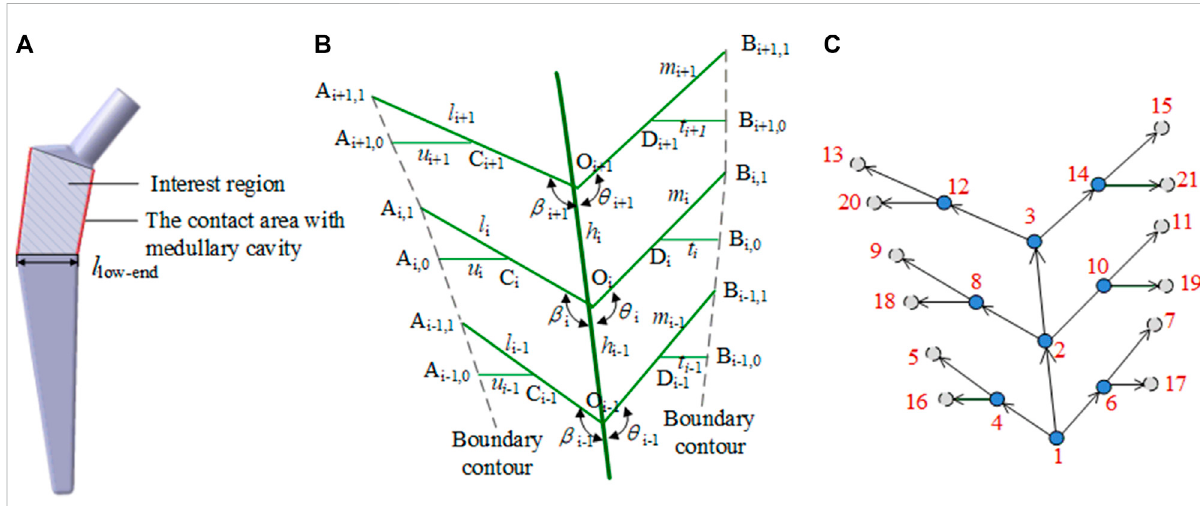
FIGURE 8 Bionic vein structure feature of the femoral stem prosthesis. (A) Interest region of the femoral stem prosthesis. (B) Semantic parameters of the interest region, mainly refers to the length of veins and the angle between veins. (C) Weighted digraph of the interest region.